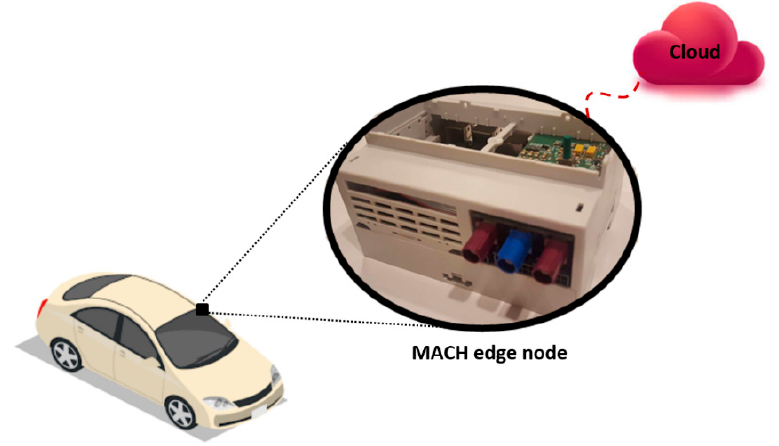
Figure 5. MACH Edge node developed in one of our ongoing projects called OPTIMUM is settled in the vehicle.